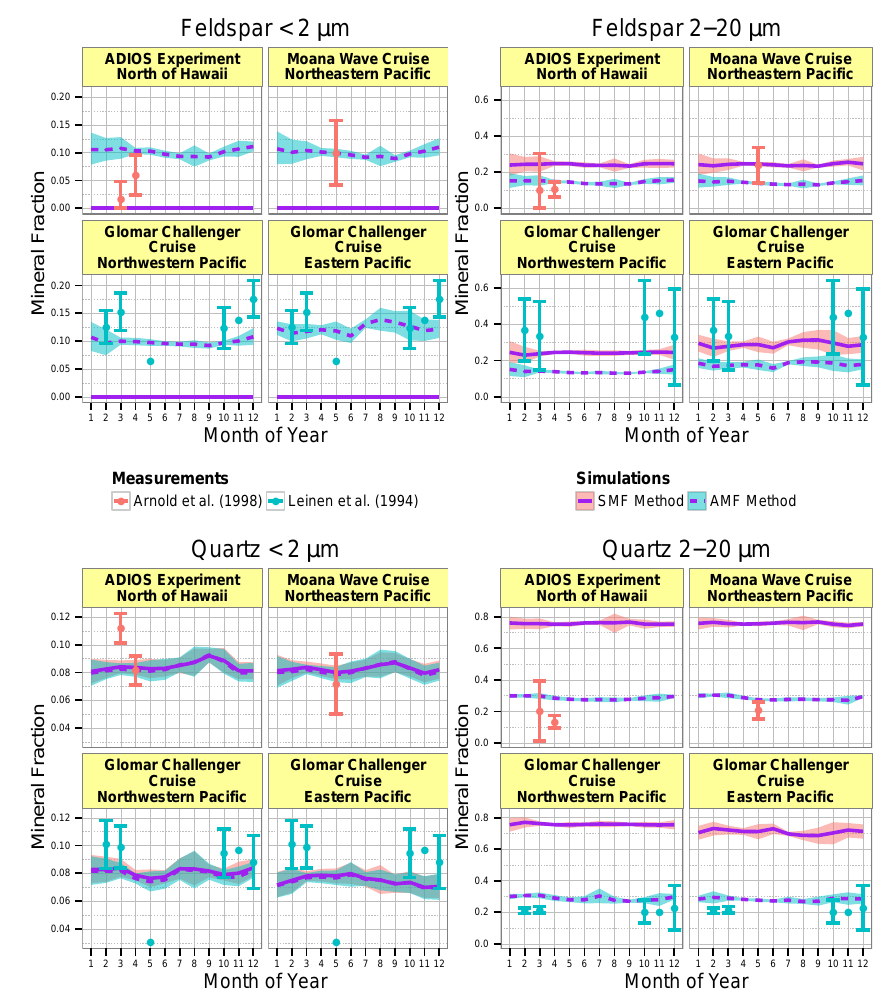
Figure 3. Same as Fig. 2 but for feldspar and